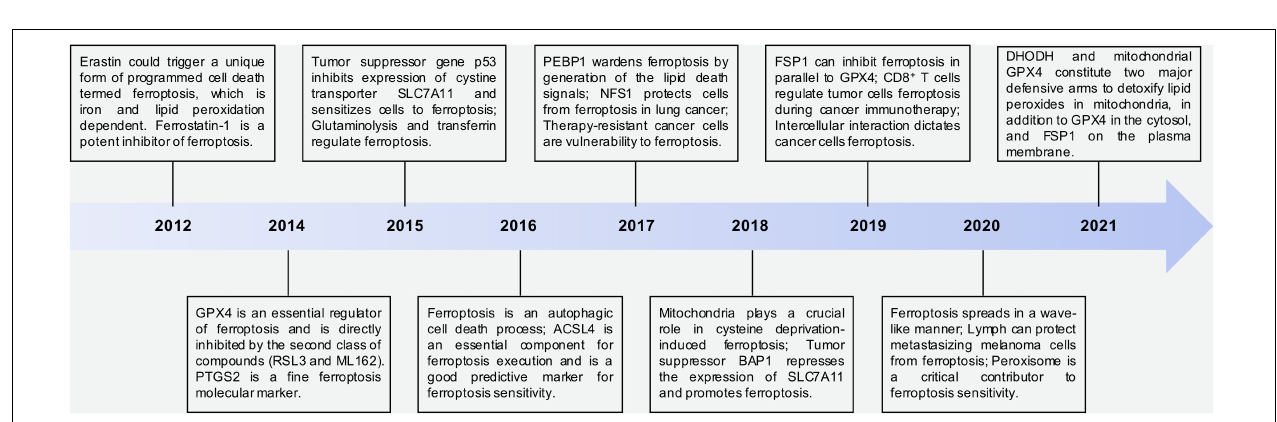
FIGURE 3 | Lipid peroxidation in ferroptosis. The increased absorption of cysteine in tumor cells is utilized to build up the cysteine–glutathione (GSH)–GPX4 axis, which plays a crucial role in detoxifying cellular oxidants and evading ferroptosis. Acyl-CoA synthetase long-chain family member 4 (ACSL4) associates with lysophosphatidylcholine acyltransferase 3 (LPCTA3) to incorporate polyunsaturated fatty acids (PUFAs) into PL-PUFA (PE), which shows higher susceptibility to peroxidation and ferroptosis. The catalytic iron inside cells appears to be the source of Fenton chemistry, which creates hydroxyl and peroxyl radicals capturing hydrogen atoms from PUFAs and triggering peroxidation of PL-PUFA. FSP1, a novel finding of ferroptosis suppressor, protects cells against ferroptosis by catalyzing the regeneration of CoQ10 using NAD(P)H. FIN56 induces ferroptosis by promoting the GPX4 degradation and lowering the CoQ10 amount.